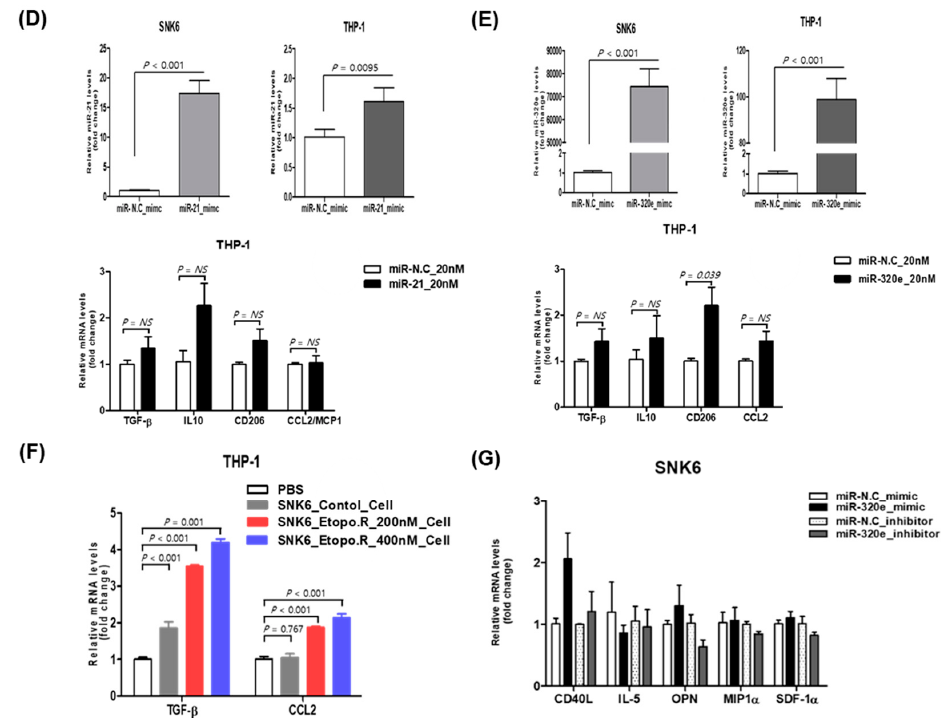
Figure 5. Effect of upregulated miR-21-5p and miR-320e on cytokine production. ( A ) KEGG (Kyoto Encyclopedia of Genes and Genomes) pathway analysis of dysregulated miRNAs was performed for NK92MI and SNK6 cells that were transfected with miR-21-5p mimic and miR-320e mimic. The list of target genes corresponding to up- and downregulated miR-21-5p and miR-320e. ( B ) After transfection of miR-21-5p and miR-320e in NK92MI and SNK6 cells, human cytokine array analysis using a culture supernatant of transfected cell lines was performed. Individual cytokines were spotted in duplicate. Cytokines induced by transfection of cells with miR21-5p are indicated by red squares, while those induced by transfection with miR320e are indicated by blue squares. Positive control spots are located at the corners of the human cytokine array. ( C ) The measurement of pixel densitometry confirmed the increased expression of several cytokines, mainly in miR-320e-transfected SNK6 cells. miR-N.C (negative control); miR-21-5p (miR-21-5p transfection); miR-320e (miR-320e transfection). ( D ) The co-culture of human monocyte THP-1 cells and SNK6 cells transfected with miR-21 showed the trend of overexpression of TGF- β , IL-10, CD206, and CCL2 in THP-1 cells, although this was not statistically significant. ( E ) The co-culture of miR-320e-transfected SNK6 cells with THP-1 cells showed a significant increase in CD206, a marker for M2-like macrophages. ( F ) The co-culture of etoposide-resistant SNK6 cells with THP-1 for 48 h showed a significant increase in TGF- β and CCL2 expression in THP-1 cells. ( G ) SNK6 cells showed differential expression of the target genes, especially CD40L and osteopontin, by overexpression and knockdown of miR-320e.